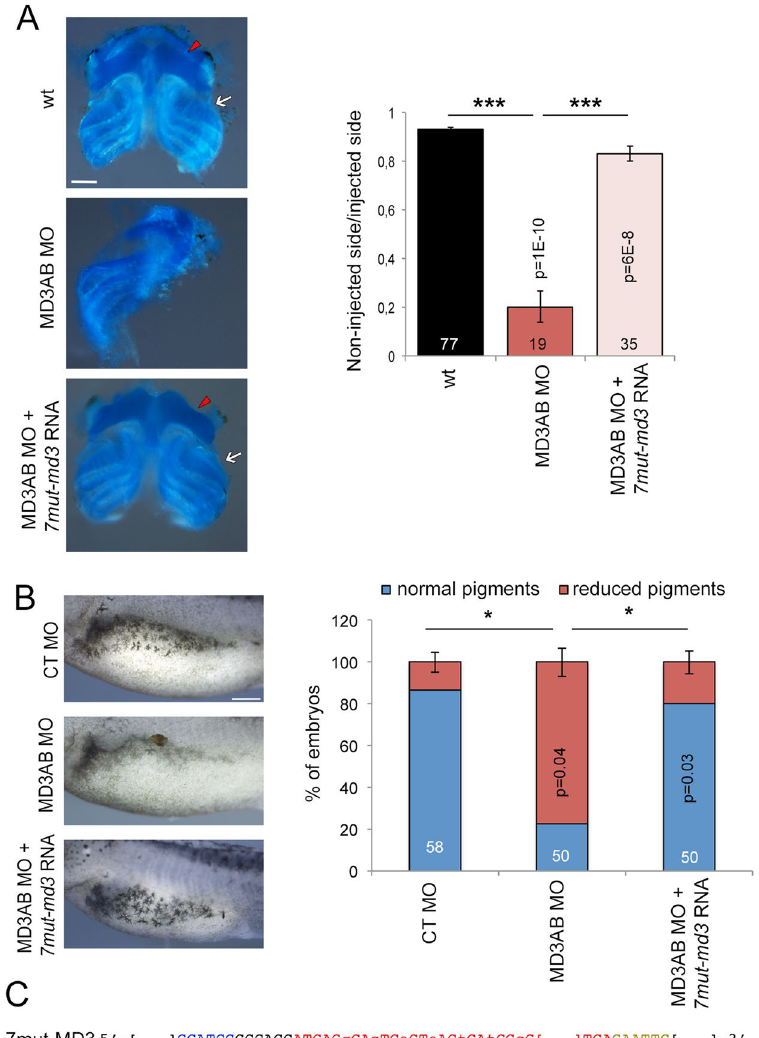
Figure 2. MarvelD3 depletion disrupts neural crest derivatives development. ( A ) Craniofacial cartilage morphology was analysed and its size measured in control, MD3AB morpholino-injected embryos and embryos co-injected with 7mut-marveld3 mRNA. Note, ceratohyal (red arrowhead) and ceratobranchial (white arrow) cartilage was reduced in MarvelD3 morphants. ( B ) The lateral line pigmentation (stage 42) pattern was analysed and quantified in control morpholino, MD3AB morpholino-injected embryos and embryos co- injected with 7mut-marveld3 mRNA. Scale bars, 500 μ m; Student t-test p values and the number of embryos analysed are indicated on the graph; blue bar, normal pigments; red bar, reduced pigments; the number craniofacial cartilage samples analysed is indicated on the graph; black bar, wt; red bar, MD3AB morpholinos; light red bar, MD3AB morpholinos + 7mut-marveld3 RNA. ( C ) 7mut-marveld3 was subcloned in pCS2 + vector (BamH1/ EcoR1). Restriction sites: underlined; mutated bases of marveld3 : underlined lower